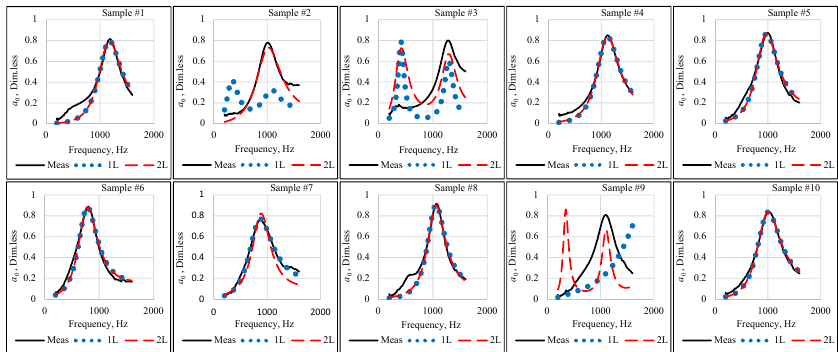
Figure 6. a 0 plots (optimization in 600–1600 Hz, measured resistivity) 00.20.40.60.81